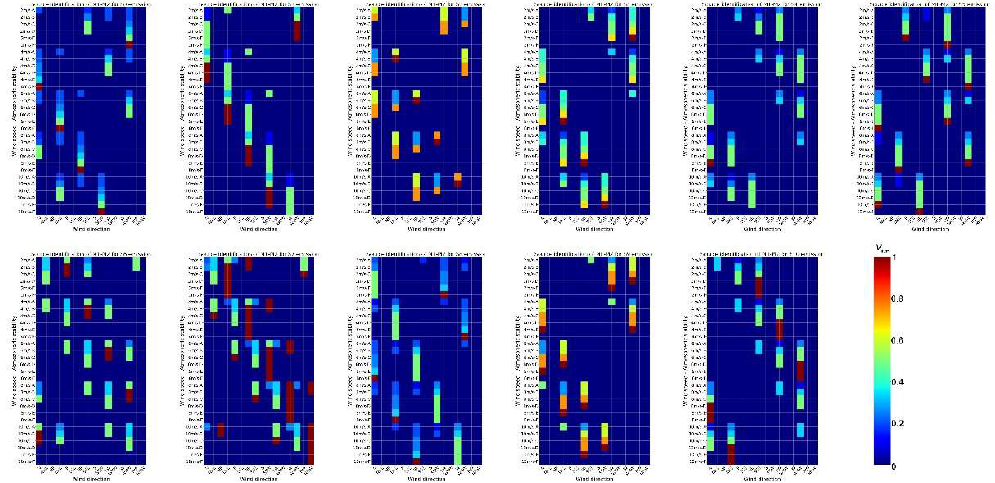
Figure A2. V e,m of integrated M 1 and M 2 for different source emissions under different meteorological conditions.